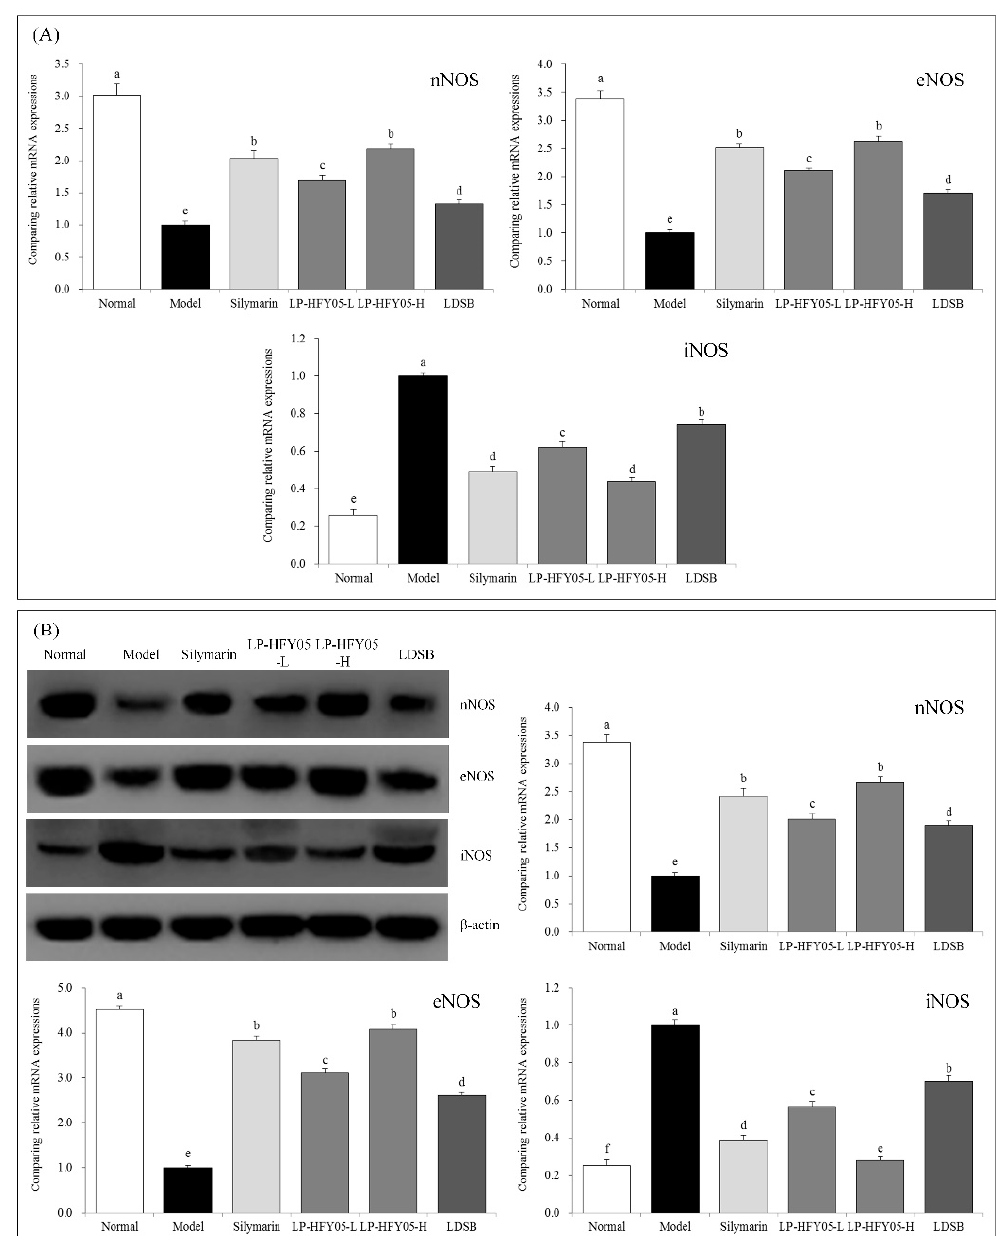
Figure 5. Neuronal nitric oxide synthase (nNOS), endothelial nitric oxide synthase (eNOS), and inducible nitric oxide synthase (iNOS) mRNA ( A ) and protein ( B ) expression in hepatic tissues of the mice. Sample data in each group came from a normal distribution. The difference in variance between the two groups was significant ( p < 0.05). a–f Mean values with different letters in the bar are significantly different ( p < 0.05) according to Tukey’s honestly significant different test. Silymarin: Mice treated with silymarin (100 mg/kg), LP-HFY05-L: Mice treated with a low concentration of Lactobacillus plantarum HFY05 (1.0 × 10 8 CFU/kg), LP-HFY05-H: Mice treated with a high concentration of Lactobacillus plantarum HFY05 (1.0 × 10 9 CFU/kg), LDSB: Mice treated with Lactobacillus delbrueckii subsp. bulgaricus (1.0 × 10 9 CFU/kg).